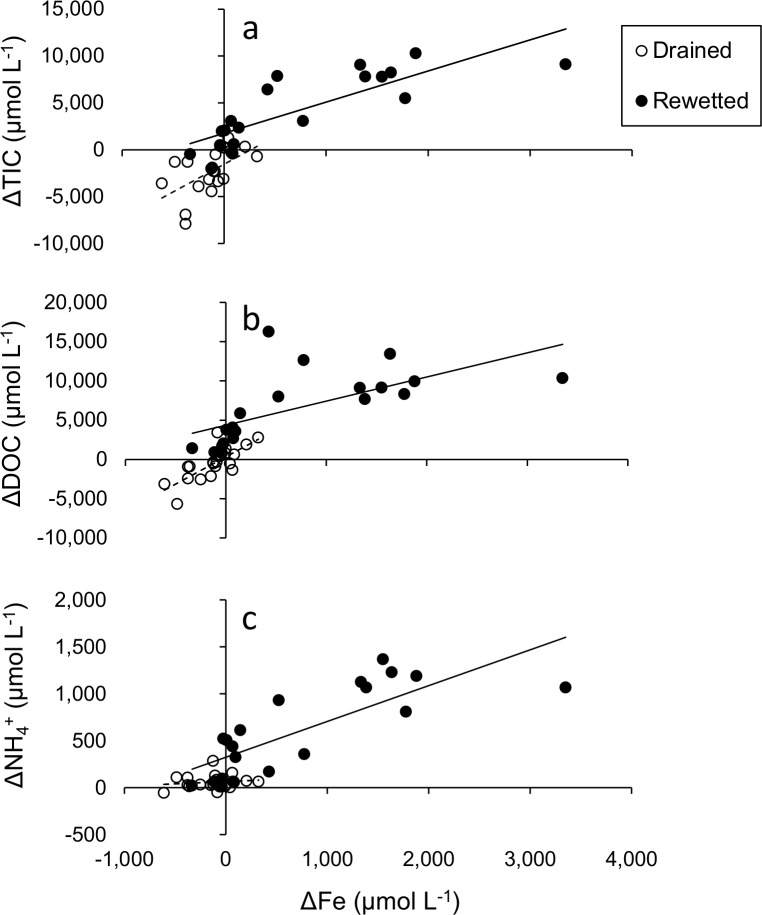
Relationship between iron, TIC, DOC and NH4+.Correlations between the change in pore water Fe concentrations (ΔFe) and the change in concentrations of (a) total inorganic carbon (ΔTIC), (b) dissolved organic carbon (ΔDOC) and (c) ammonium (ΔNH4+) (in μmol L-1) in 20 rewetted and 20 drained soil cores over 127 days (n = 4 sites).